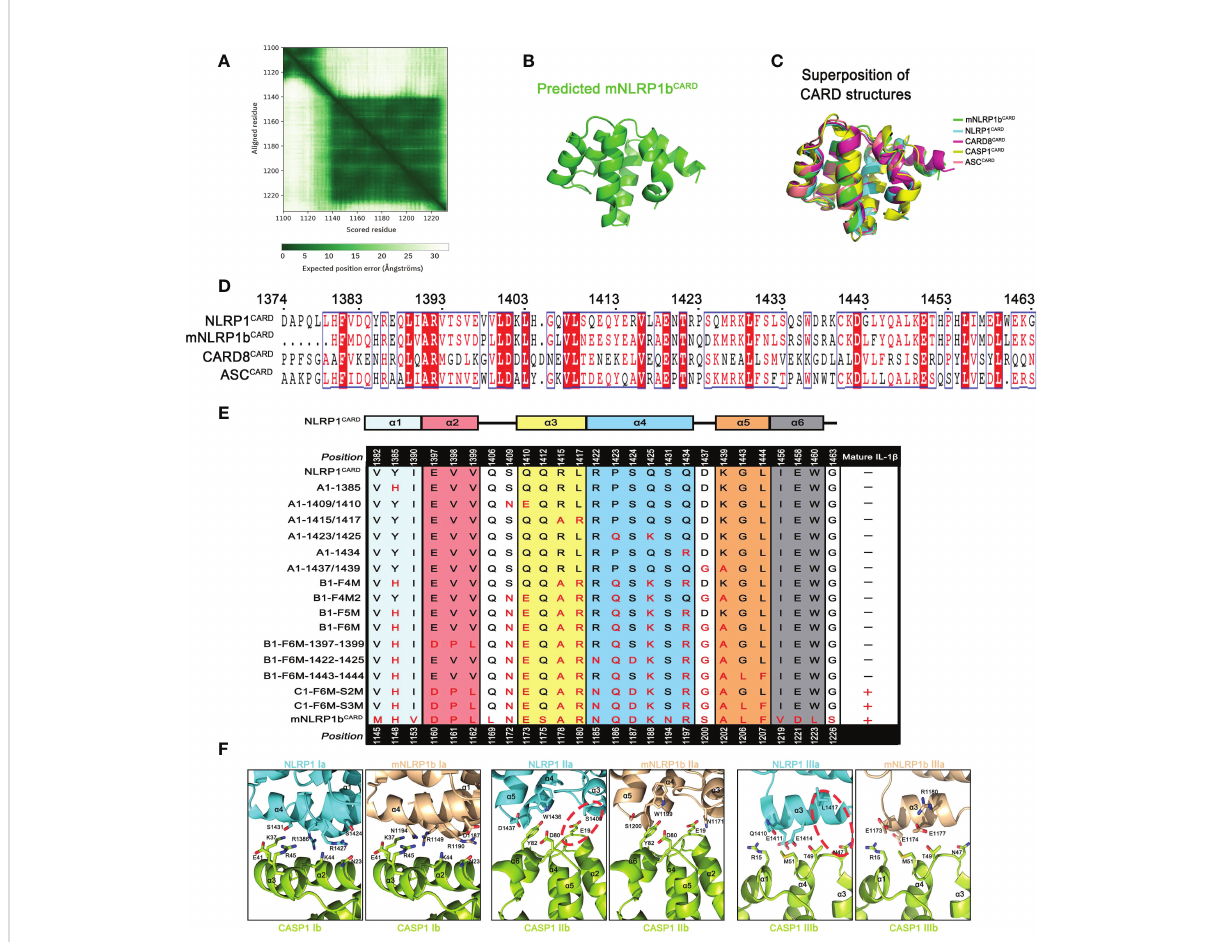
FIGURE 5 Various CARD interfaces were critical for ASC dependence in NLRP1 and CARD8 in fl ammasome. (A) The AlphaFold ’ s predicted aligned error of mNLRP1b encoding residues 1100-1233 structure. (B) Predicted structure of the CARD domain of mNLRP1b. (C) Superposition of all fi ve known CARDs from mNLRP1b (green), NLRP1 (cyan), CARD8 (magenta), CASP1 (yellow), and ASC (lightpink). (D) Sequence alignment analysis of hNLRP1 CARD , mNLRP1b CARD , CARD8 CARD and hASC CARD . Amino acid position is shown on the top of the sequences. (E) Mapping critical hNLRP1 CARD interaction sites for ASC-de fi cient NLRP1 in fl ammasome activation based on mNLRP1b CARD sequence. The secondary structure of hNLRP1 CARD is indicated on the top. (F) Structural compatibility for Type I, II, and III interaction residues of CASP1 CARD with human NLRP1 CARD or murine mNLRP1b CARD . Red line is used to label possible clashes in detailed CARD-CARD interaction